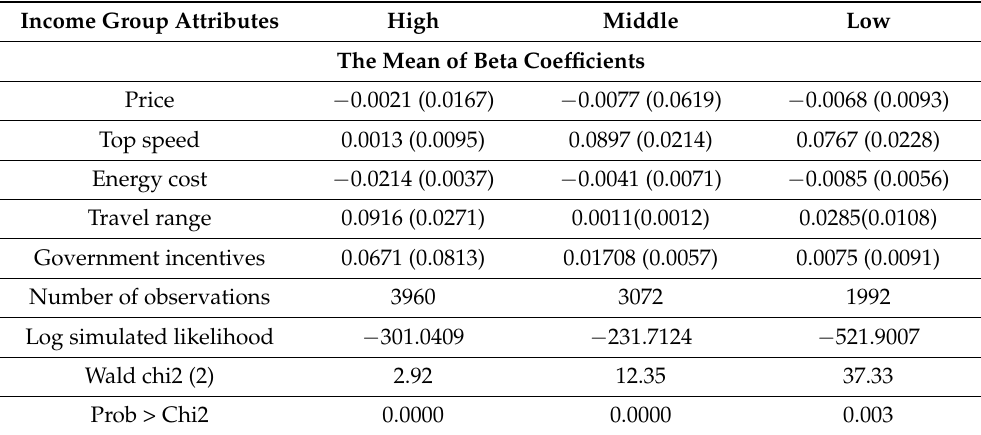
Table 9. Customers’ sensitivity by income group.